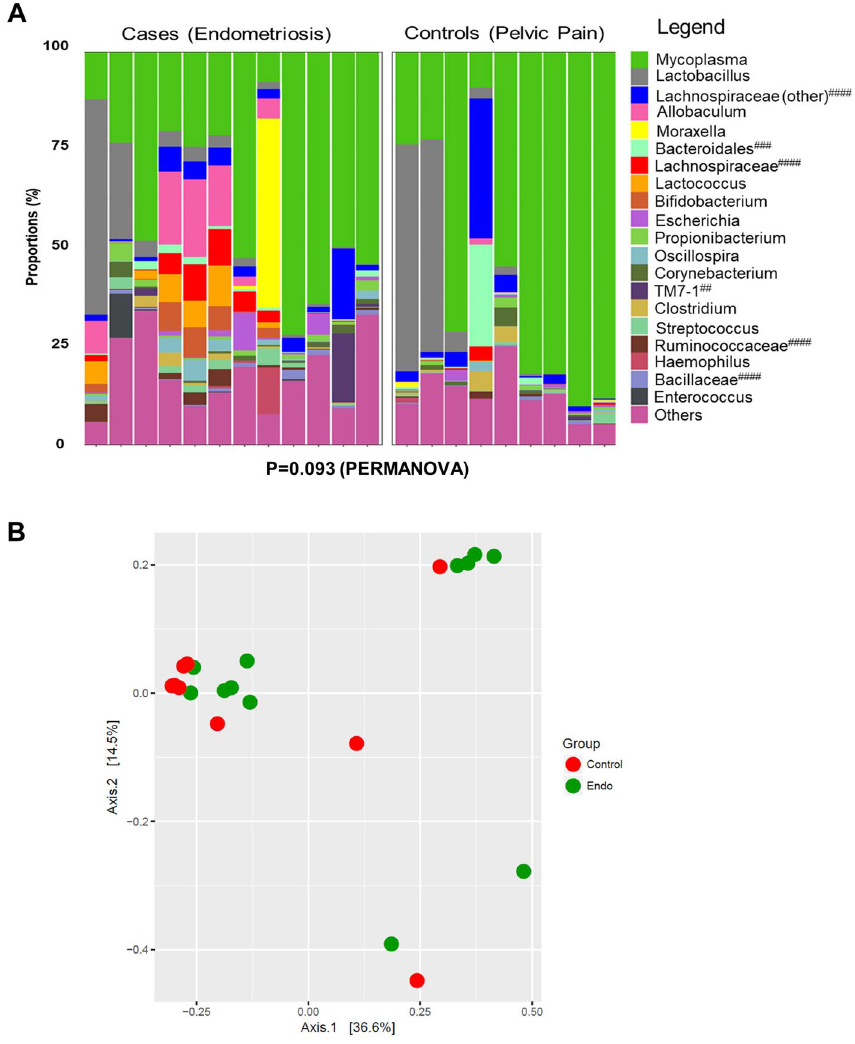
Figure 2. Beta-diversity of patients with endometriosis verges on being significantly greater than symptomatic controls. ( A ) The top 20 bacterial genera in the endometrial microbiota were plotted by relative abundance as taxa bar charts and compared between patients with surgically confirmed endometriosis (N = 12) and surgically confirmed controls (N = 9). Each bar represents the endometrial microbiota of one individual. Each colour represents a different genus of bacteria, as indicated in the legend. Endometrial microbiota are ordered left to right in descending order of the relative abundance of lactobacilli. Patients with endometriosis (as a group) had an endometrial flora that verged on being significantly different from the endometrial microbiota of surgically confirmed, symptomatic controls (β-diversity, p = 0.09, PERMANOVA). ##: Resolved to bacterial class. ###: Resolved to bacterial order. ####: Resolved to bacterial family. ( B ) The principal coordinate analysis plots (PCoA) demonstrated the beta-diversity of the endometrial microbiota at the OTU level based on the Bray– Curtis dissimilarity matrix (endometriosis = green dots, controls = red dots). Axes = eigenvalues, a metric whose magnitude indicates the amount of variation captured in the PCoA